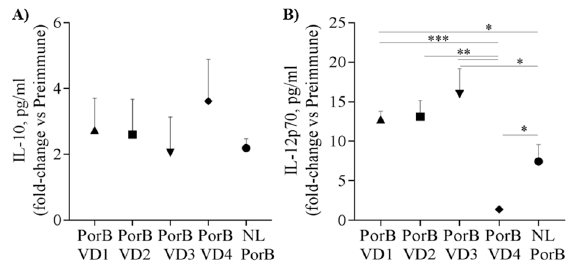
Figure 7. Immunization with NL PorB and PorB/VDs induces different cytokine responses. Serum cytokine levels were measured by ELISA and quantified in pg/mL. Values from immune sera of individual mice (week 6) in each group were normalized to the pooled pre-immune sera from the same group and expressed as fold-change ± SEM. ( A ) IL-10 and ( B ) IL-12p70. *; **; *** p < 0.05 by unpaired t -test. Table 2. Immunization with NL PorB and PorB/VDs induces different cytokine responses. Cytokine PorB/VD1 PorB/VD2